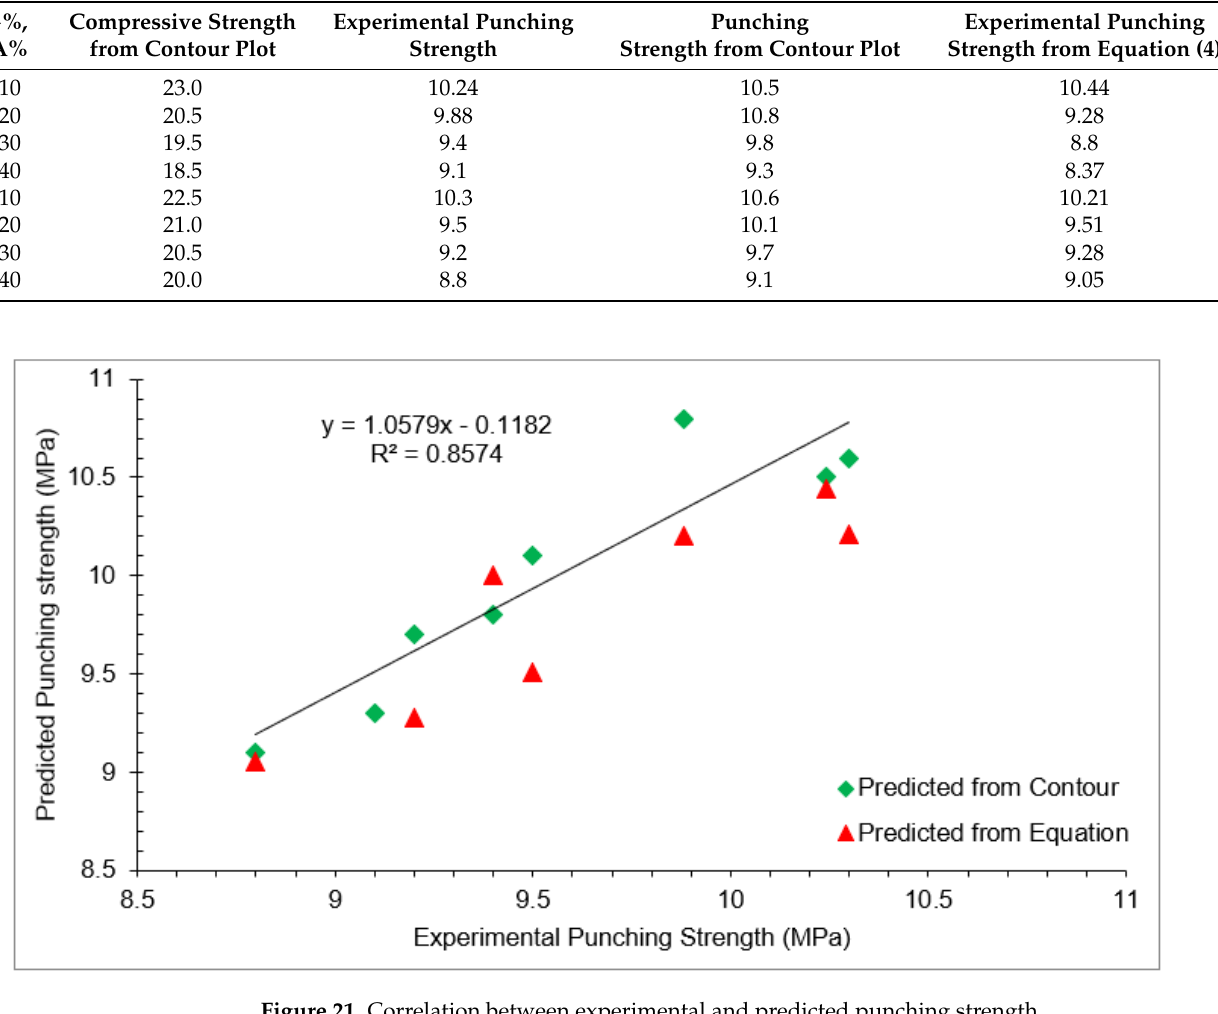
Table 6. Experimental and predicted punching strength.